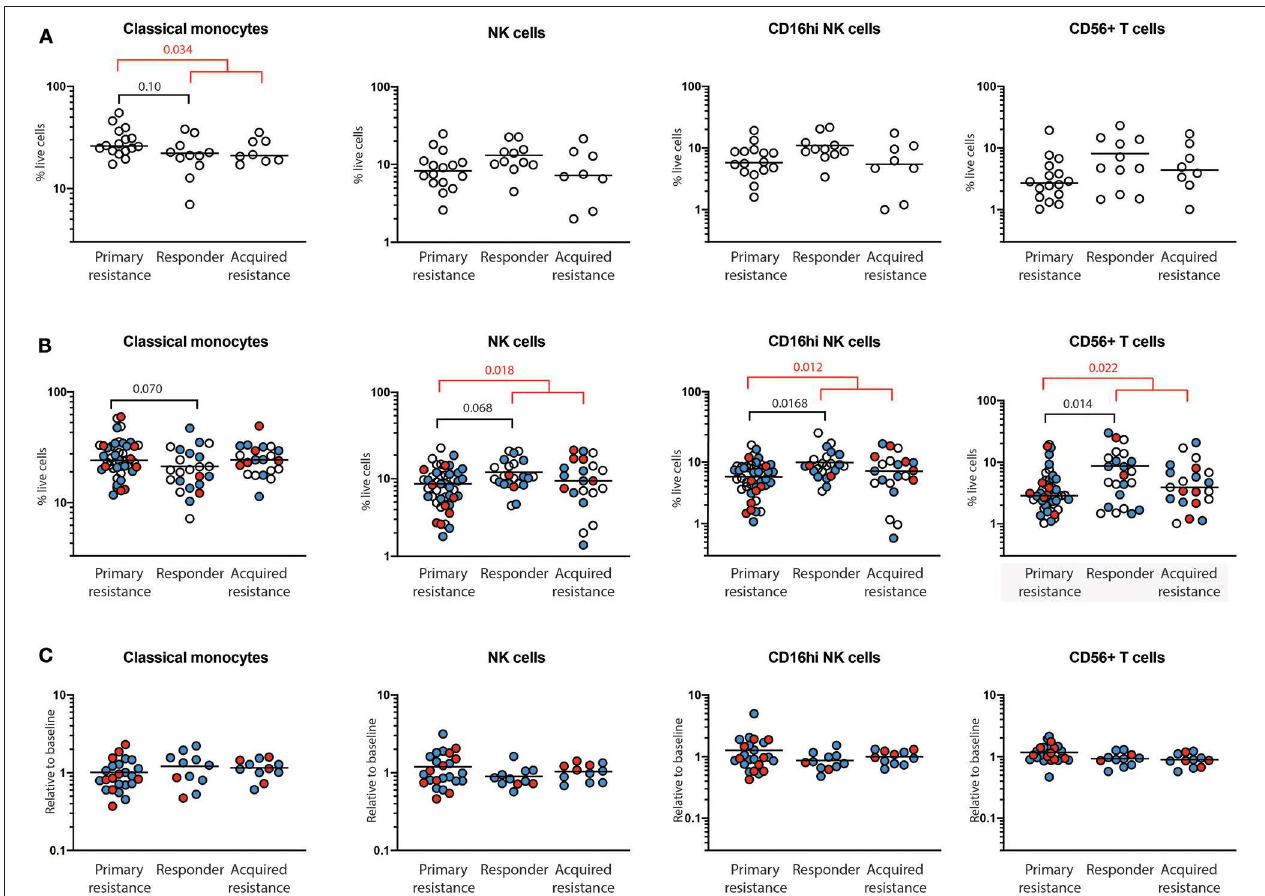
FIGURE 3 | Quantification of immune cells populations using mass cytometry. PBMCs from primary resistance, responder and acquired resistance groups were analyzed for multiple T cell, B cell, NK cell, and myeloid populations, as illustrated in Supplementary Figures 2, 3 . Only populations that differed between groups are shown. (A) Frequencies of baseline cell populations in each of the groups. Each individual sample is indicated by a circle, with the group mean shown as a bar. (B) Frequencies of cell populations from all timepoints in each of the groups. Baseline, open circles; week 6, blue filled circles; 1 year, red filled circles. (C) Changes in frequencies within individual subjects over time. Values at 6 weeks, expressed as a proportion of baseline values, are indicated by blue filled circles while values at year 1, expressed as a proportion of baseline values, are indicated by red filled circles. Differences in frequencies of immune cell populations between primary resistance, responder, and acquired resistance groups were assessed using ANOVA followed by Tukey’s multiple comparisons test and p -values are shown in black. Differences between primary resistance and primary responder (i.e., pooled responder and acquired resistance) groups were assessed using an unpaired t -test and p -values are indicated in red. Where no p -values are indicated, the relevant tests indicated p >